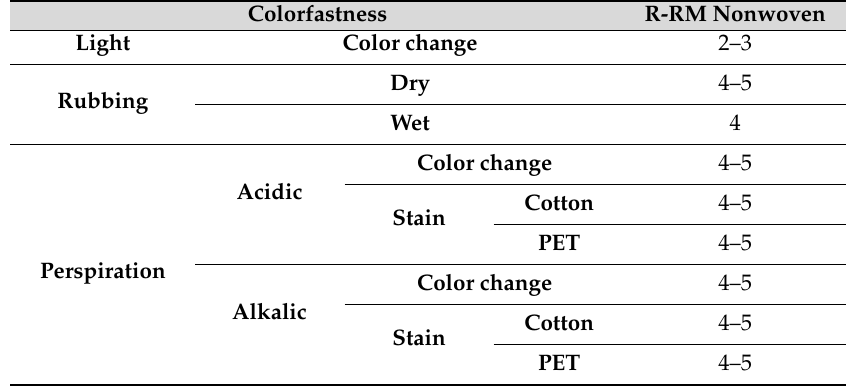
Table 3. Results of light, rubbing, and perspiration fastness for the dyed R-RM nonwoven.